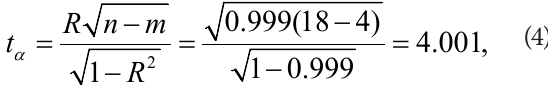
The determination coefficient R 2 = 0.999 indicates a close relationship between these factors and the volume of income from the Ukrainian NTS. The model test for validity using the F-criterion showed that the model is reliable ( F > F = 3.18). tab